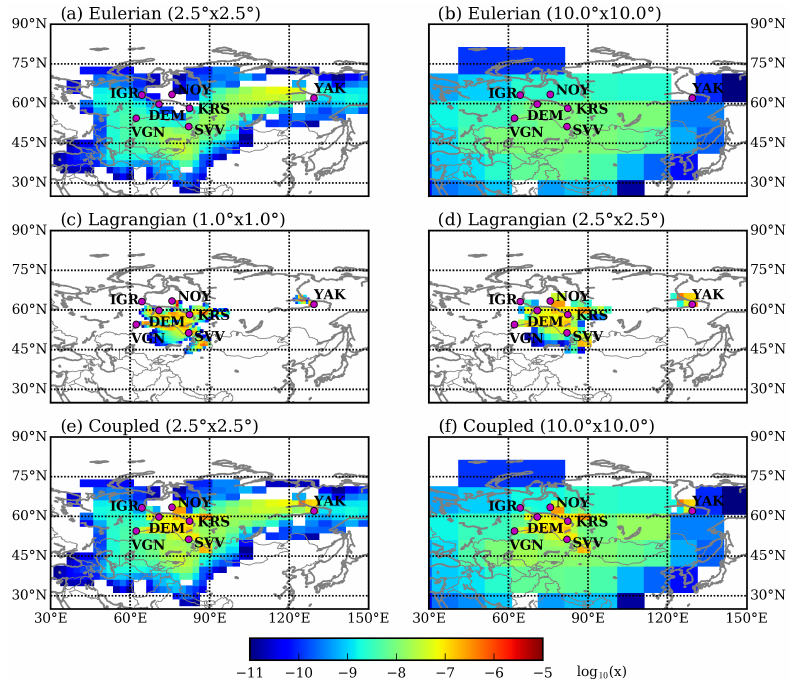
Figure 8. Comparison of sensitivities of CO 2 concentrations (ppm(µmolm − 2 s − 1 ) − 1 ) at day 2 (see Sect. 5.2.2) calculated using: (a) the Eulerian adjoint with a resolution of 2.5 ◦ , (b) the Eulerian adjoint with a resolution of 10.0 ◦ , (c) the Lagrangian model on the native model grid with a resolution of 1.0 ◦ , (d) as for (c) , but aggregated on the grid with a resolution of 2.5 ◦ , (e) the coupled adjoint model; results from the Lagrangian adjoint model were aggregated on the grid with a resolution of 2.5 ◦ , (f) as for (e) , but the resolution of the Eulerian adjoint model was 10.0 ◦ . Note the logarithmic color scale for the